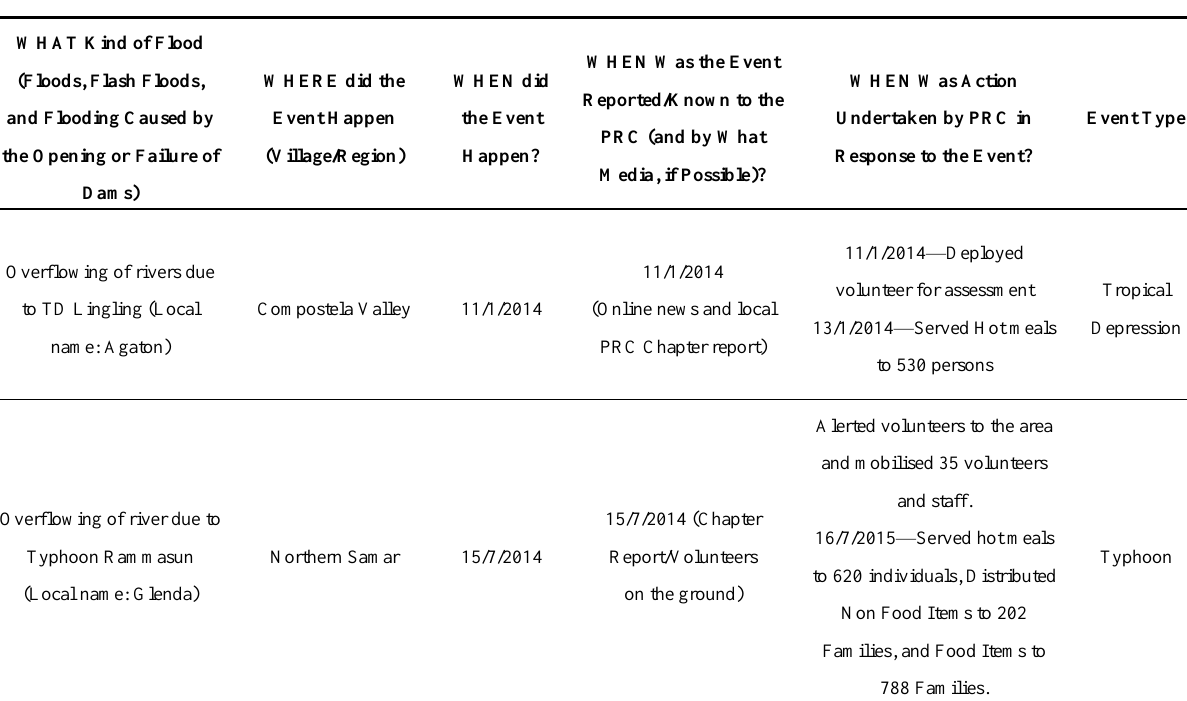
Table 1. Extract from event occurrence and response dataset provided by the PRC (date: day/month